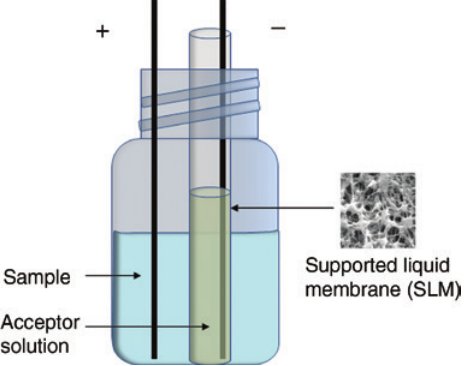
Figure 1: Schematic illustration of electromembrane extraction (EME) with hollow fiber